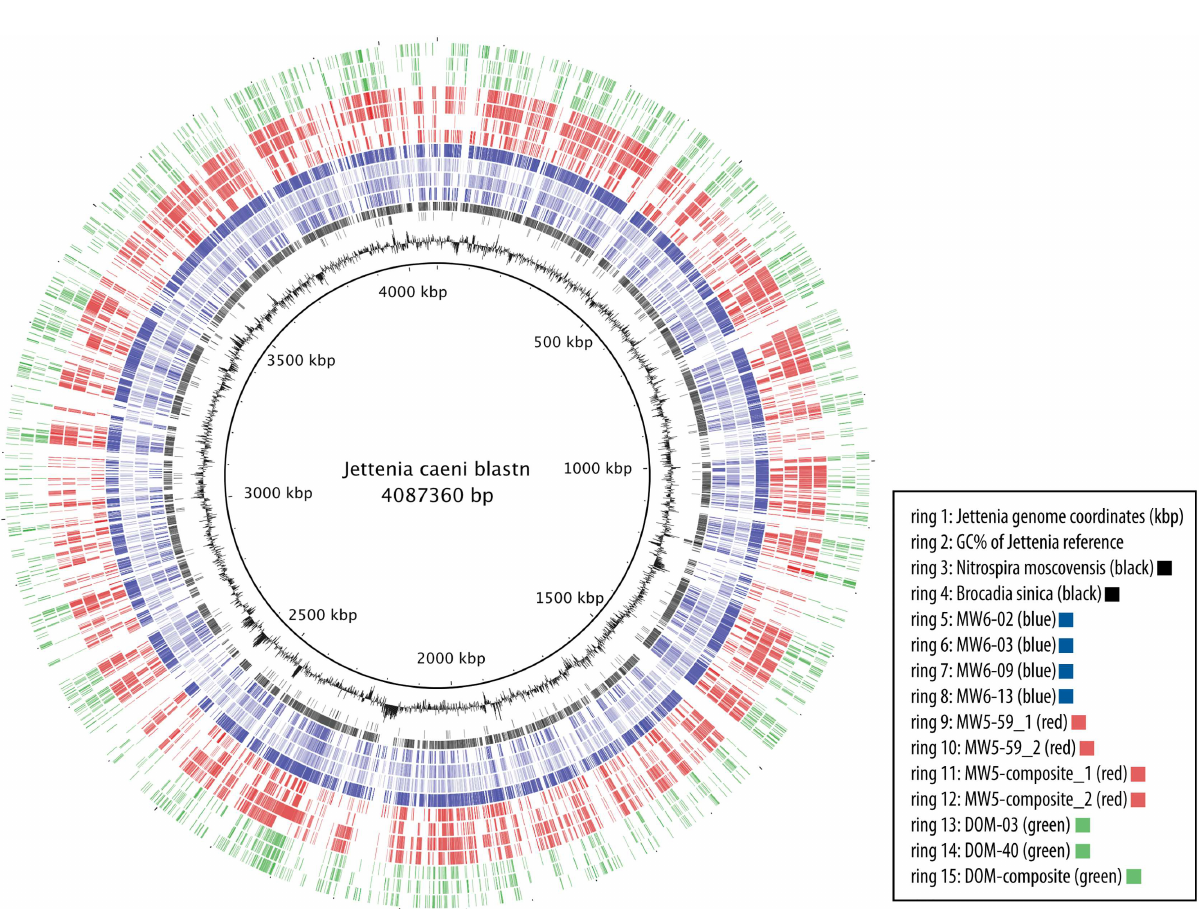
Fig 2. Homology of assembledBrocadiaceae genomes to the Jettenia caeni referencegenome. BRIG [37] was used to comparethe Brocadiaceae genomic bins to the reference Jettenia caeni by BLASTN [38]. Radialcolored bars in the concentricrings indicate